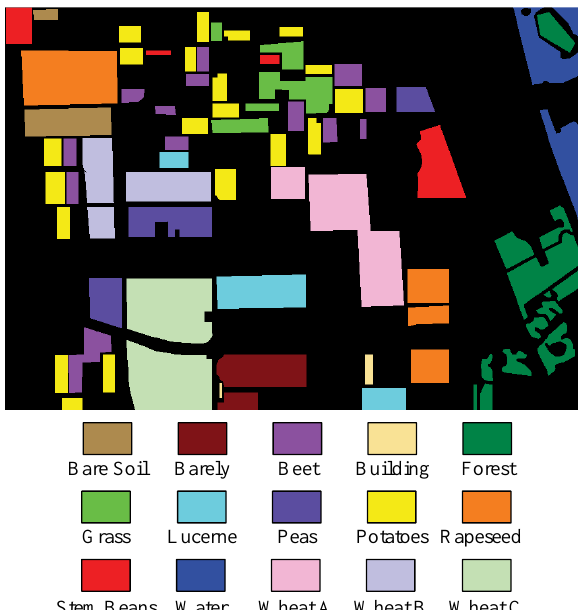
Figure 4. Ground truth for Flevoland area and its legend.